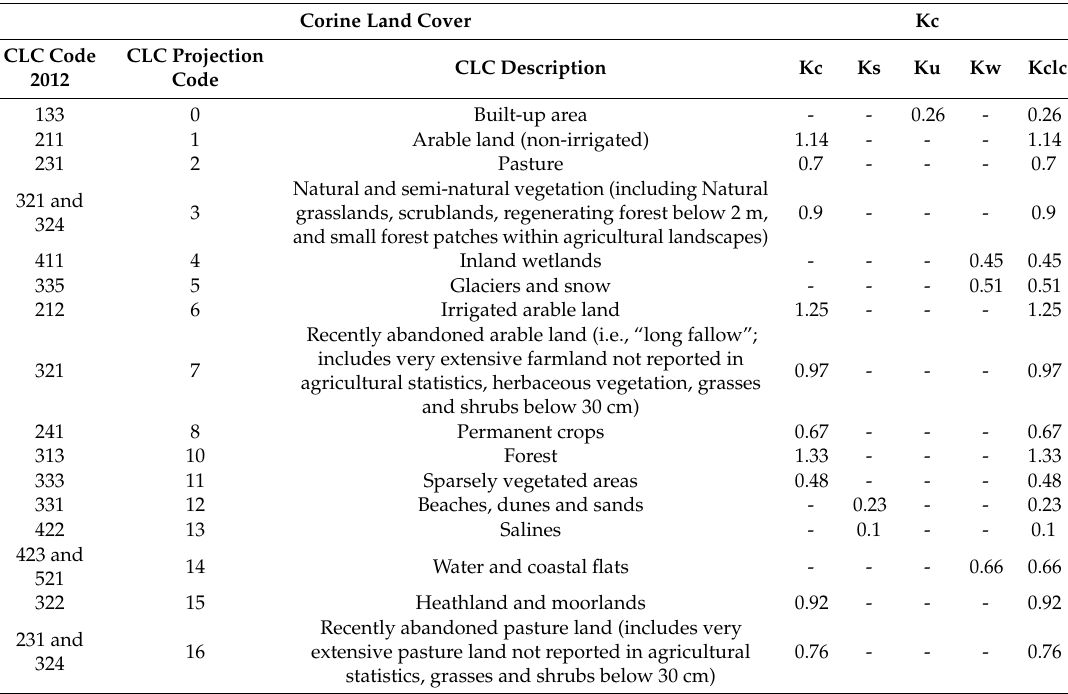
Table 2. Corine land cover classes and calculated annual Kc for future scenarios in the Grand Est